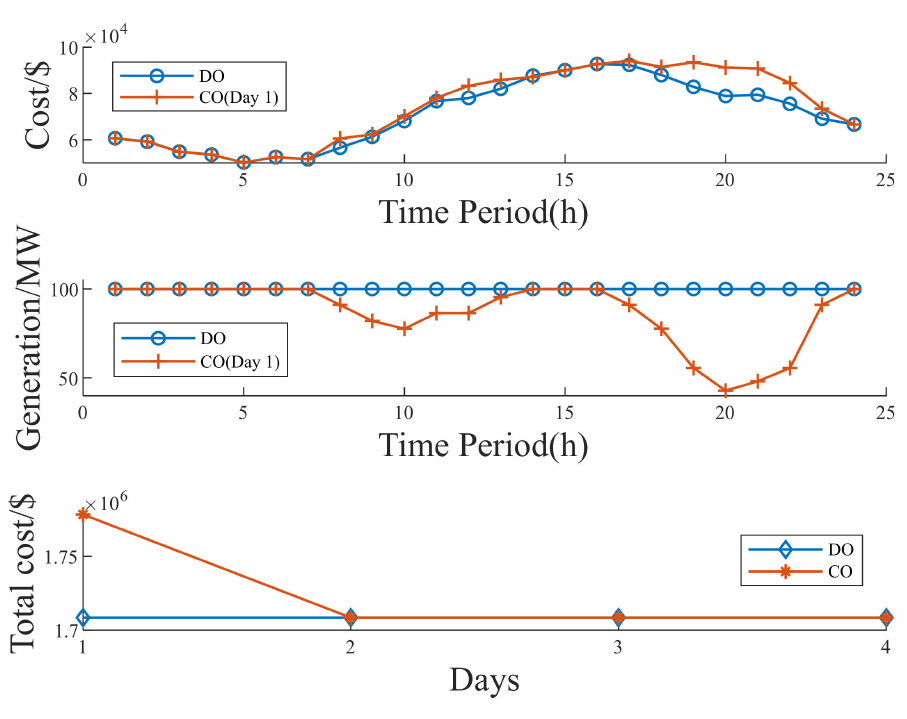
Figure 9. Hourly and total cost of ENO, hourly generation of